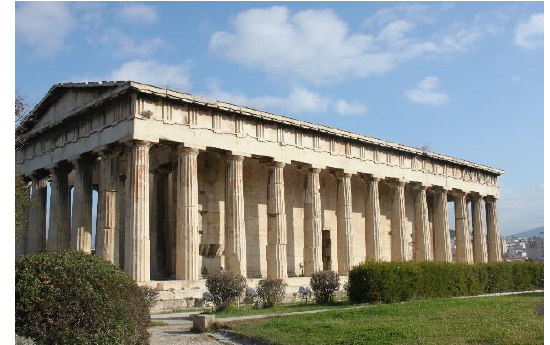
Figure 13. The Temple of Hephaestus in the Ancient Agora of Athens